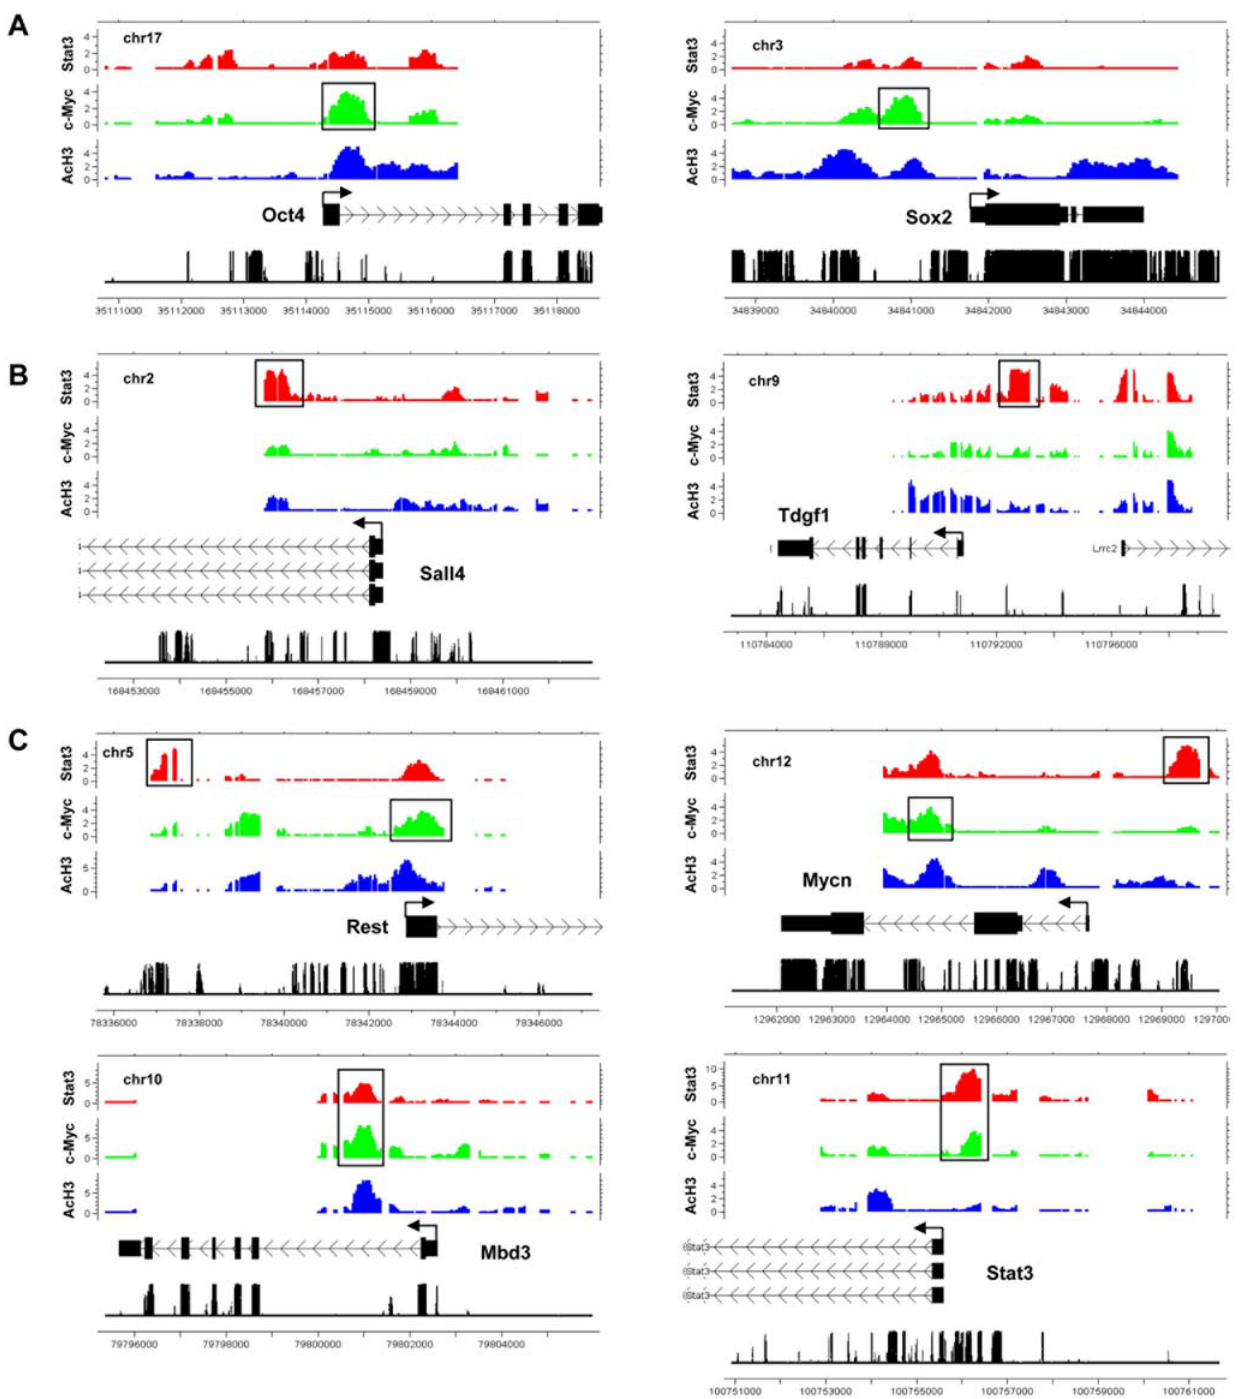
Figure 2. Genomic maps of Stat3 and c-Myc binding at pluripotency-related gene loci. Stat3 and c-Myc genomic binding site and acetylated histone H3 (AcH3) profiles at ES cell enriched gene loci. Representative (A) c-Myc bound genes (Oct4, Sox2), (B) Stat3 bound genes (Sall4, Tdgf1), and Stat3 and c-Myc co-bound genes (Rest, Mycn, Mbd3, Stat3). Moving average (MA) enrichment values adjusted to log2 are shown. Chromosome number, sequence position, and conservation are also indicated on the plot.